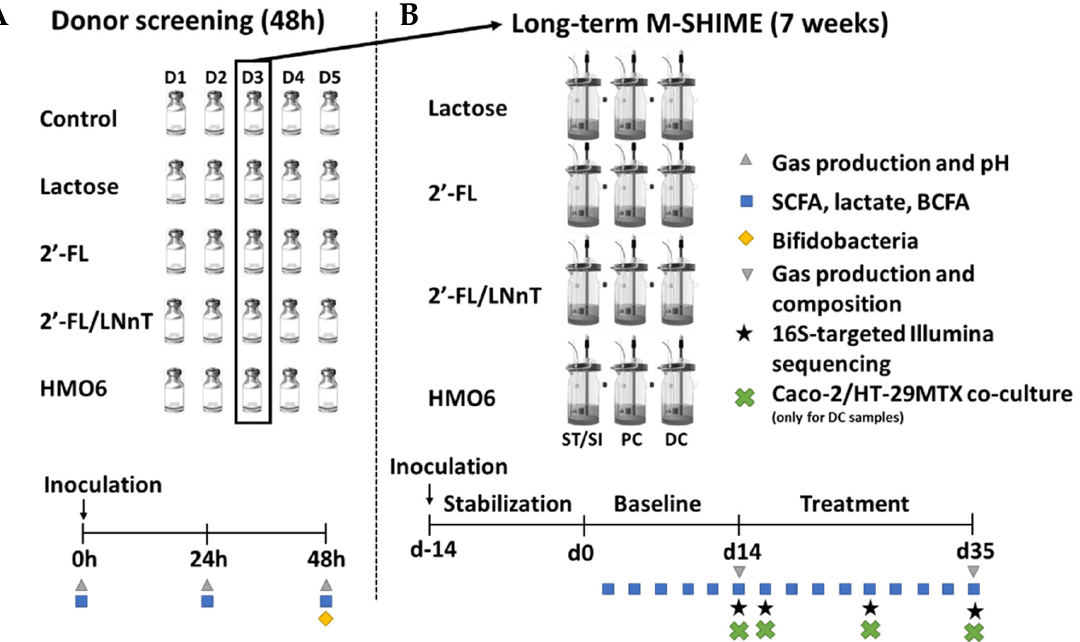
Figure 1. Schematic representation of the experimental setup: (A) Short-term incubations to screen fecal samples from five infant donors (48 h); (B) Long-term baby M-SHIME ® study using the selected fecal sample from the screening of a single infant. 2 ′ -FL = 2 ′ -fucosyllactose; LNnT = lacto-N-neo- tetraose, mixture of six human milk oligosaccharides [2’-FL, Lacto-N-tetraose (LNT), LNnT, difuco- syl-lactose (LDFT), 3 ′ SL, 6 ′ SL (HMO6). D1-D5 = donors. SFCA = short-chain fatty acid; BCFA = branched-chain fatty acid; ST/SI = stomach/small intestine; PC = proximal colon; DC = distal colon; baby M-SHIME ® = mucosal simulator of the human intestinal microbial ecosystem.